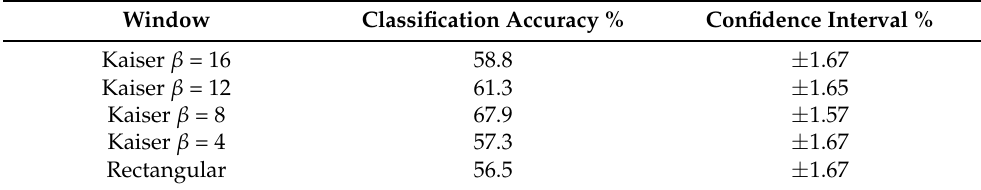
Table 3. Listing of Key Window Function